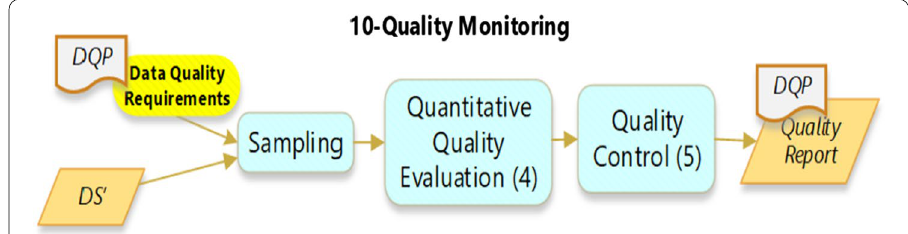
Fig. 11 Quality monitoring